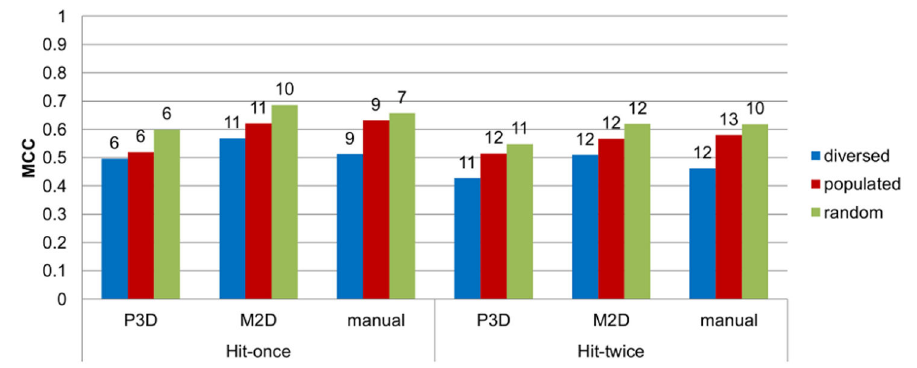
Figure 4. The optimized values of MCC for each possible scheme. The optimized values of MCC for each possible scheme. The length of combination is shown at the top of the bars. The composition of combinations based on the manual clustering approach is shown in Figure